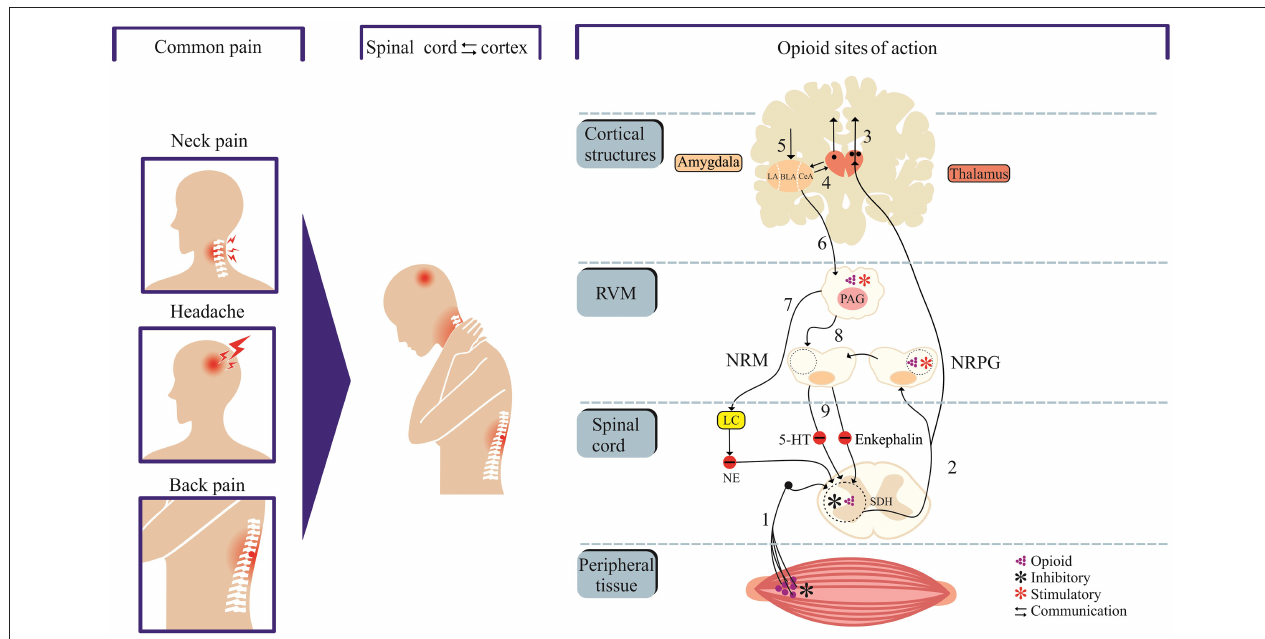
FIGURE 1 | Neural circuits of pain and opioid site of action. Cortex and spinal cord communication modulate pain perception and offer targets for opioid drugs. Neural projections from peripheral tissue transmit nociceptive inputs through primary afferent fibers (1) to the spinal dorsal horn (SDH) before reaching the thalamus (2). Neural projections from thalamus target cortical sites (centers of pain processing, cognition, perceptions and integration) and amygdala (“emotional site”). The amygdala receives nociceptive inputs from the thalamus and cortex. The descending pain control system is mediated through projections from structures such as amygdala and hypothalamus to the periaqueductal gray matter (PAG) which in turn communicates with the rostral ventromedial medulla (RVM). The neural components within RVM [the nucleus raphe magnus (NRM) and nucleus reticularis paragigantocellularis (NRPG)] project to the spinal or medullary dorsal horns to directly or indirectly enhance or attenuate nociceptive transmission. The 5-hydroxytryptamine (5-HT) and enkephalin-containing neurons in the NRM project to the substantia gelatinosa of the dorsal horn and exert an inhibitory influence on transmission. Opioids sites of action include dorsal horn and peripheral terminals of nociceptive afferent neurons where opioids inhibit transmission. Opioids stimulate PAG and NRPG (blue asterisk), which in turn project to the rostroventral medulla. The locus coeruleus (LC) which receives inputs from the PAG releases noradrenalin to the dorsal horn, which in turn inhibits nociceptive transmission. Areas labeled 2–4 in red color and 5–8 in green color represent ascending and descending tracts,